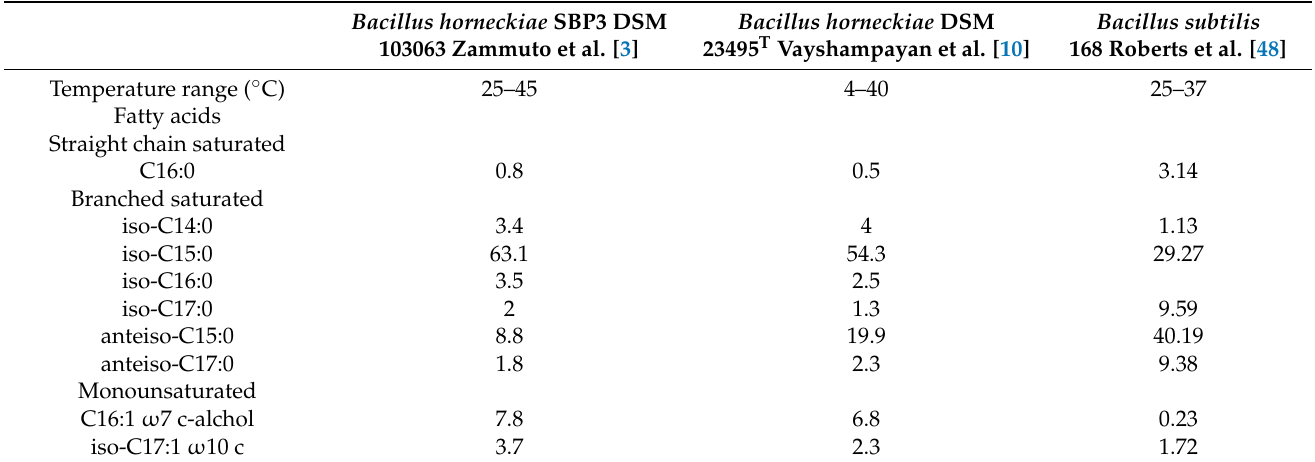
Table 3. Percentages of the relative abundance of fatty acid methyl esters in B. horneckiae SBP3, B. horneckiae DSM 23495 T and B. subtilis